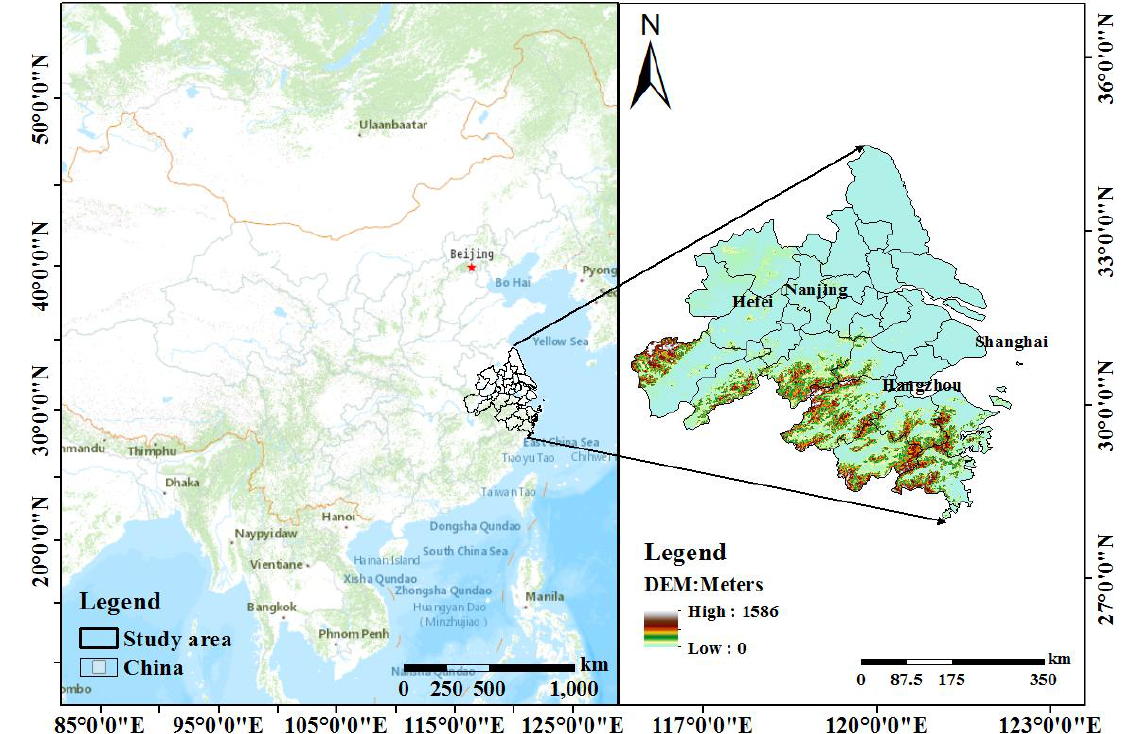
Figure 1. Geographical location of the study area.